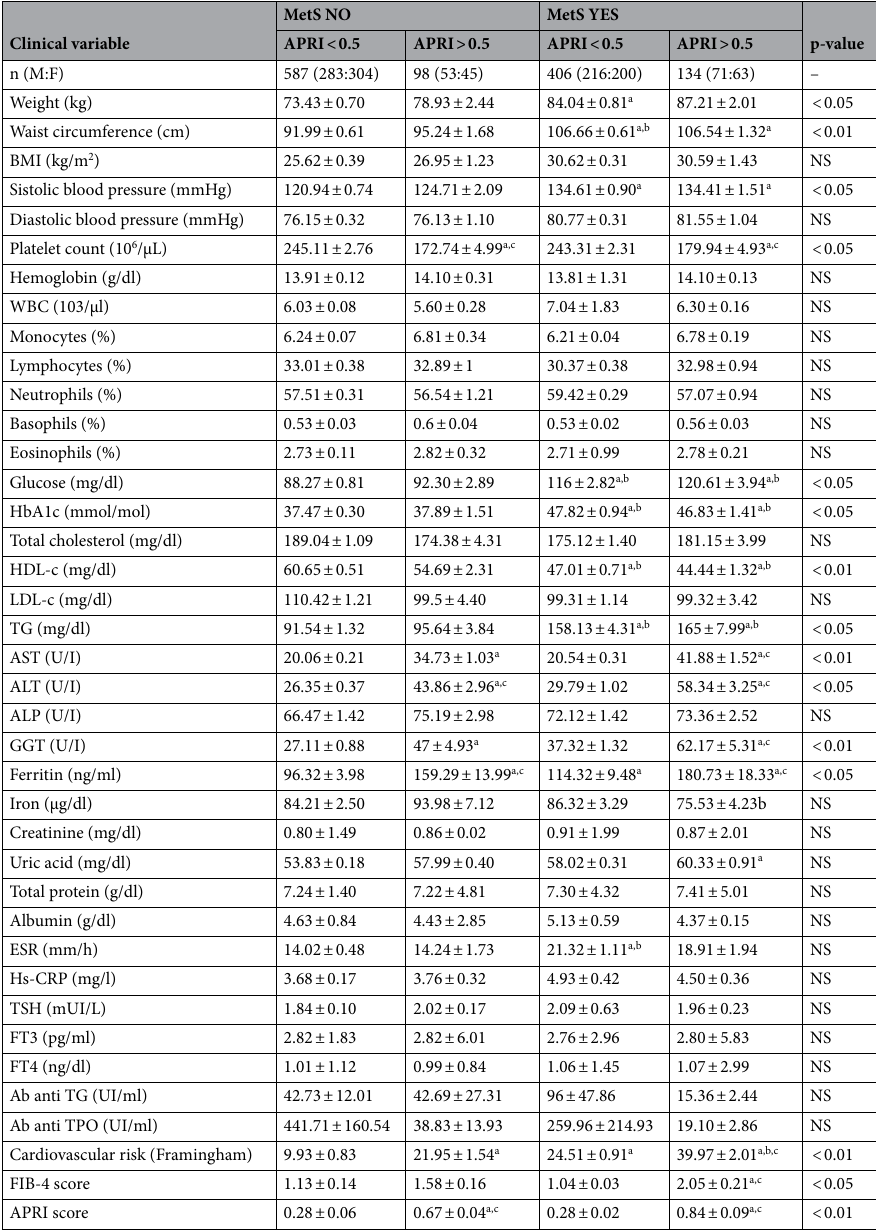
Table 2. Clinical comparison between non-metabolic and MetS subjects with normal and elevated APRI score in the study population. Data are age-adjusted and presented as mean ± SEM (standard error of the mean). BMI Body Mass Index, WC waist circumference, SBP systolic blood pressure, DBP diastolic blood pressure, TC total cholesterol, TG triglyceride, HDL-C high-density lipoprotein cholesterol, LDL-C low-density lipoprotein cholesterol, HbA1c glycosylated hemoglobin, Hs-CRP high-sensitivity C reactive protein, ESR erythrocyte sedimentation rate, GGT gamma-glutamyltransferase, AST aspartate transaminase, ALT alanine transaminase, ALP alkaline phosphatase. a Indicates statistical significance compared to MetS NO with APRI < 0.5 group. b Indicates statistical significance compared to MetS NO with APRI > 0.5 group. c Indicates statistical significance to MetS YES with APRI < 0.5